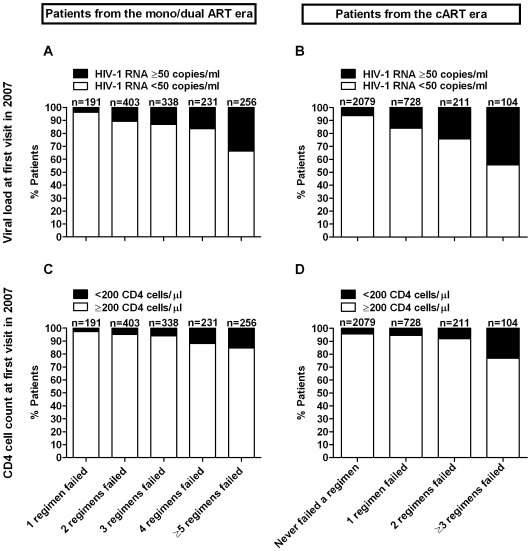
Distribution of viral loads and CD4 cell counts at first follow-up visit in 2007 (visit 1) according to the number of previous virologically failed regimens.The upper panels show HIV-1 RNA counts for patients who started therapy in the mono/dual era (A) and in the cART era (B). Lower panels show CD4 cell counts for patients from the mono/dual era (C) and for patients from the cART era (D), respectively. By definition all patients from the mono/dual era failed at least one regimen.